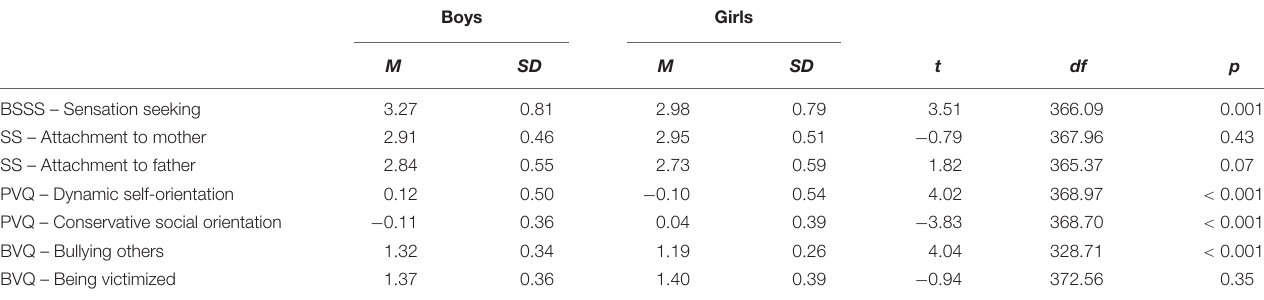
TABLE 2 | Descriptive statistics for boys and girls.